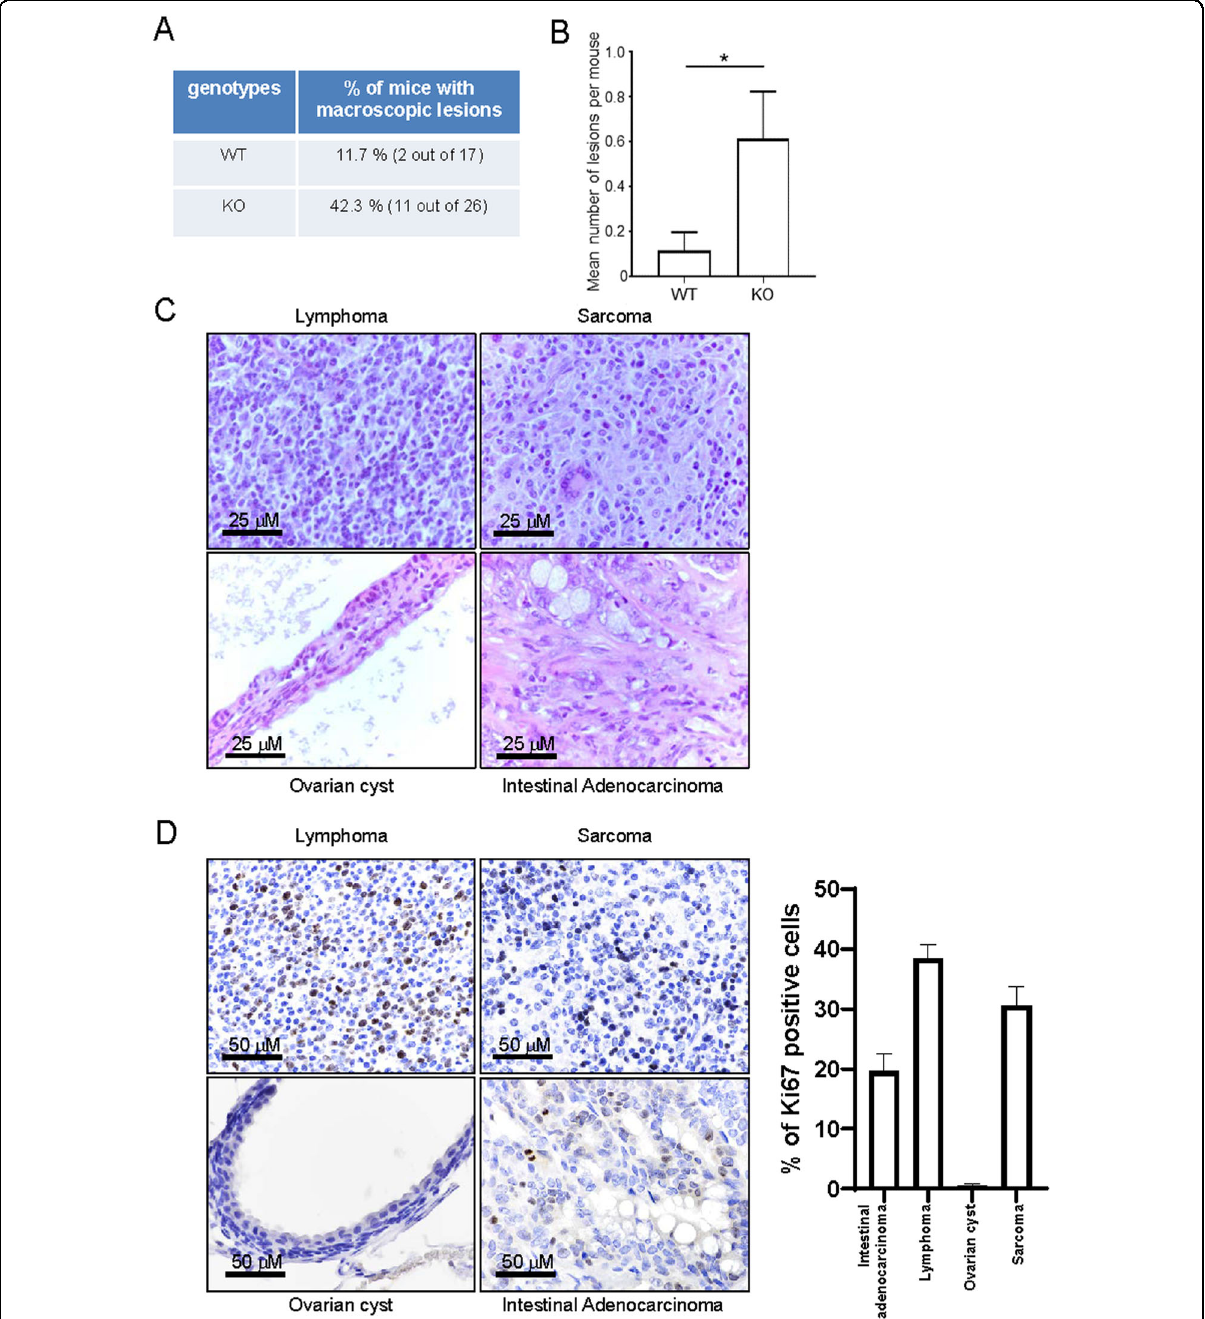
Fig. 1 Pla2r1 loss increases spontaneous tumor formation in old mice. A – C Macroscopic lesions of 20-month-old Pla2r1 − / − mice ( n = 26) and their control littermates ( n = 17) were counted and analyzed histologically to characterize each lesion. A Percentage (%) of mice displaying macroscopic lesions for each genotype was calculated. P = 0.04 according to two-tailed Fisher exact test. B The mean number of lesions per mouse for each genotype was computed and presented as mean ± SEM. The p value was calculated using Mann – Whitney test. * p < 0.05. C Representative histopathological images of lesions are shown. D Indicated tumors were prepared and analyzed by immunohistochemistry against Ki67 proliferation marker to determine the percentage of positive cells. Representative images and histograms are shown (mean±